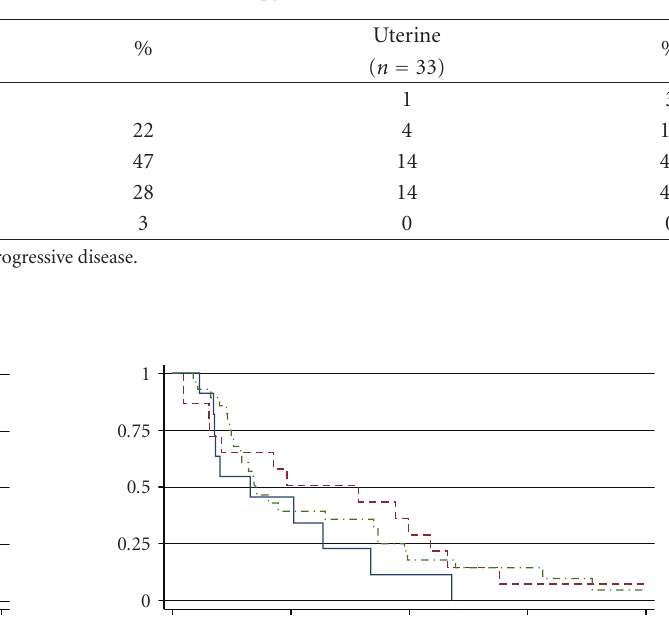
Table 3: Response rate of first line chemotherapy.